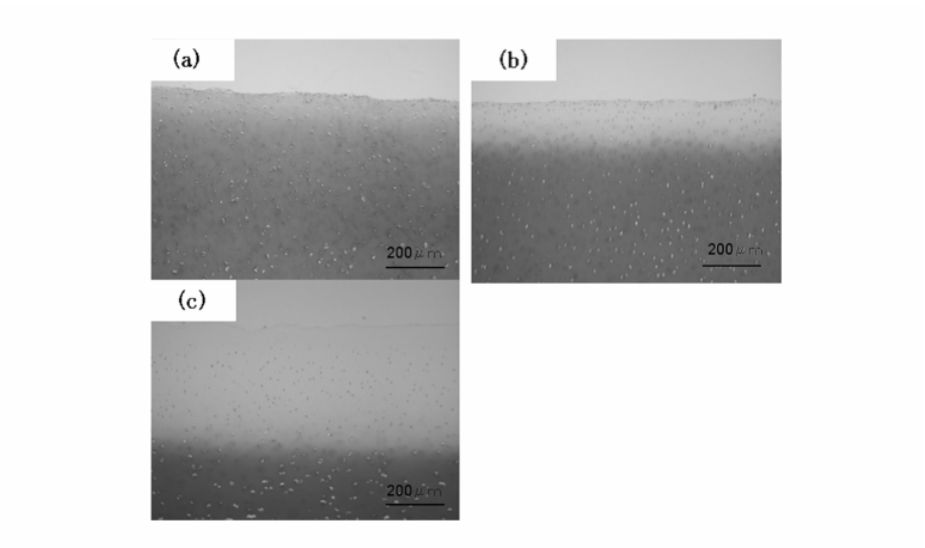
Fig. 10 Photomicrographs of pig articular cartilage before (a), after 4 hours (b), and after 9 hours (c) of collagenase digestion (Safranin O